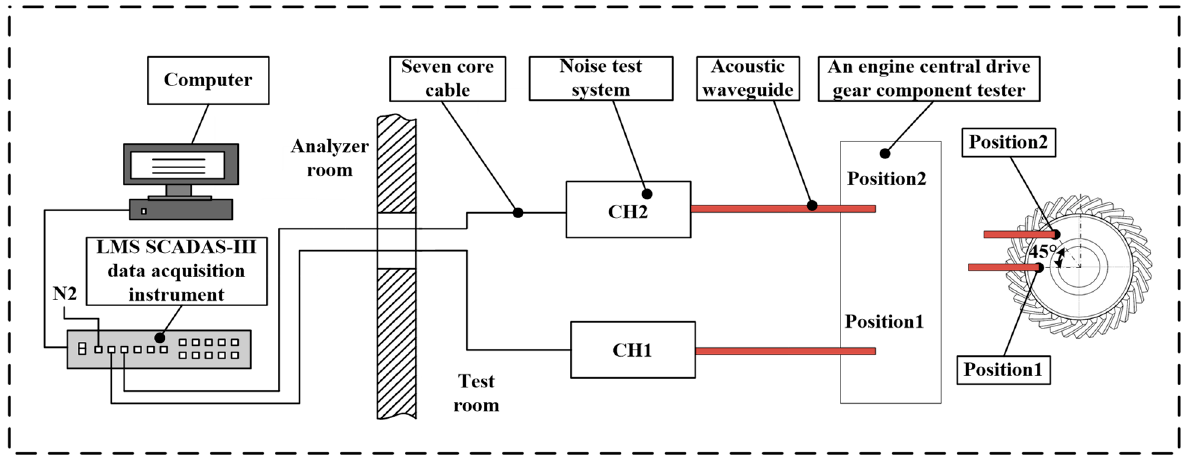
Figure 3. Connection diagram of acoustic waveguide system.